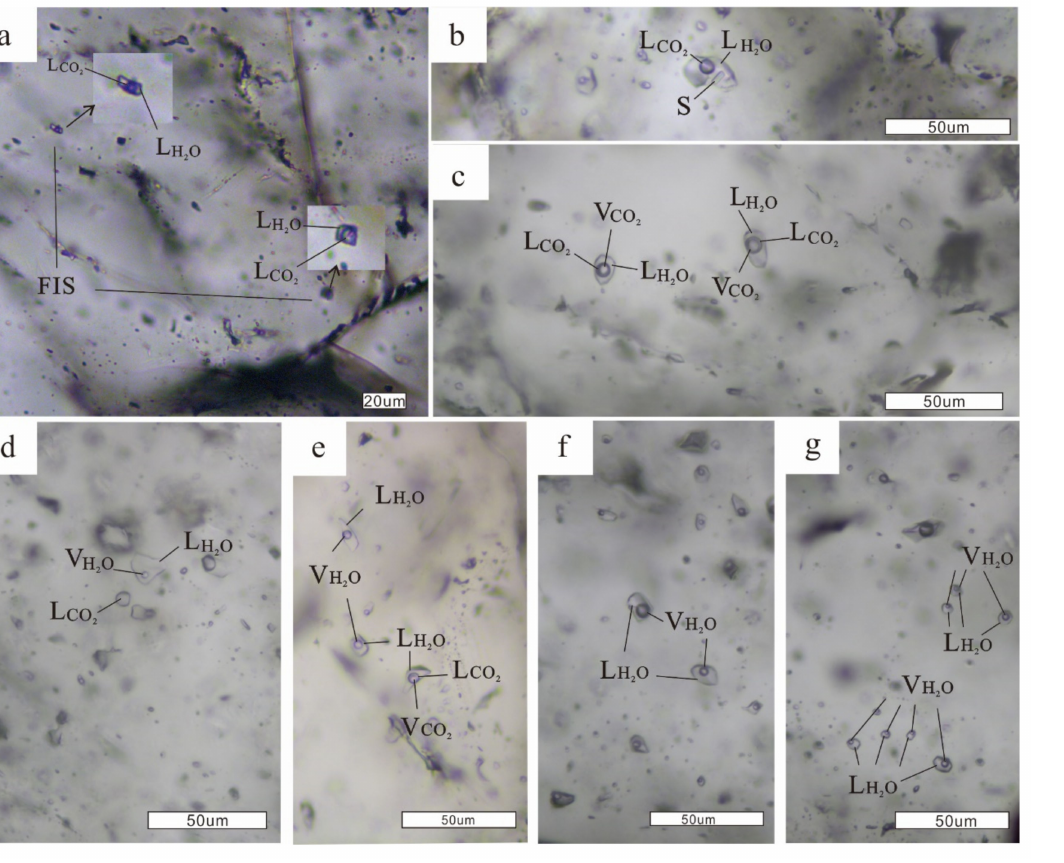
Figure 5. Photomicrographs of fluid inclusions in quartz from the Juyuan tungsten deposit. ( a ) C-type fluid inclusions with various vapor/liquid in early-stage quartz; ( b ) S-type fluid inclusion in early-stage quartz; ( c ) C-type fluid inclusion in early-stage quartz; ( d ) coexisting W-type and PC-type fluid inclusions in intermediate-stage quartz; ( e ) coexisting W-type and C-type fluid inclusions in intermediate-stage quartz; ( f , g ) W-type fluid inclusions in late-stage quartz. Abbreviation: V CO , vapor CO 2 ; L CO , liquid CO 2 ; V H , vapor H 2 O; L H , liquid H 2 O; S, daughter 2 2 2 O 2 O